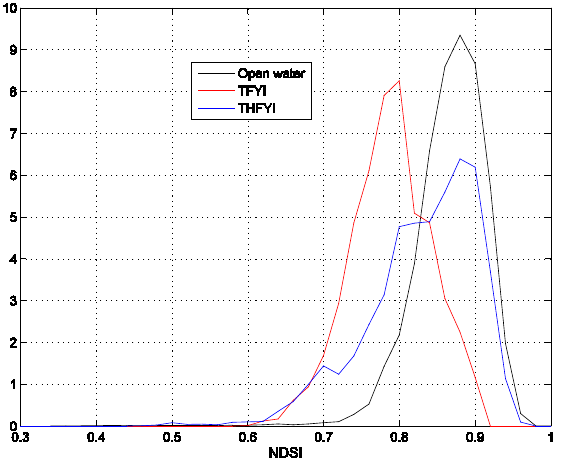
Figure 20. The MODIS normalized difference snow index (NDSI) between band 4 (0.555 μm) and 6 (1.6 μm) TOA reflectances for open water, thin first-year ice (THFYI) and thick first-year ice (TFYI) under winter conditions in the Kara Sea in May 2009. THFYI includes nilas, young ice, and pancake ice, and its surface may be snow-free or covered with thin snow layer. The bin width of the probability density functions is 0.02.